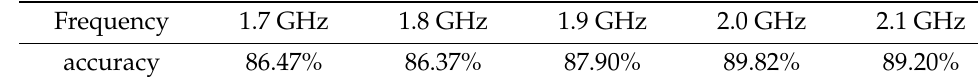
Figure 16. Bi-LSTM resulted Doppler images and the corresponding labels in sequence S1 at the five frequencies, namely ( a ) 1.7 GHz, ( b ) 1.8 GHz, ( c ) 1.9 GHz, ( d ) 2.0 GHz, ( e ) 2.1 GHz. Table 3. Average recognition accuracy of Bi-LSTM network at five frequencies.